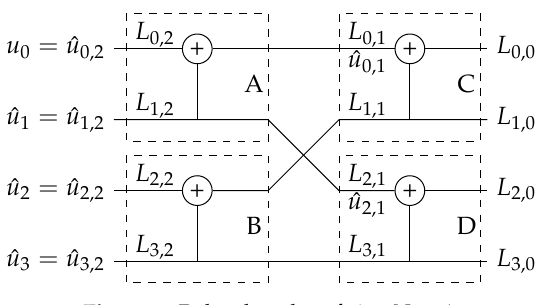
Figure 6. Polar decoder of size N =